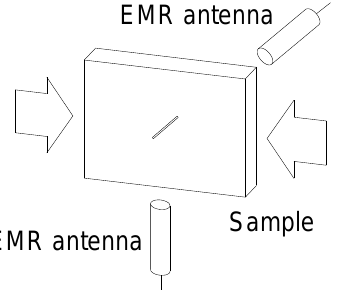
Figure 2. Schematic diagram of the EMR antenna layout.